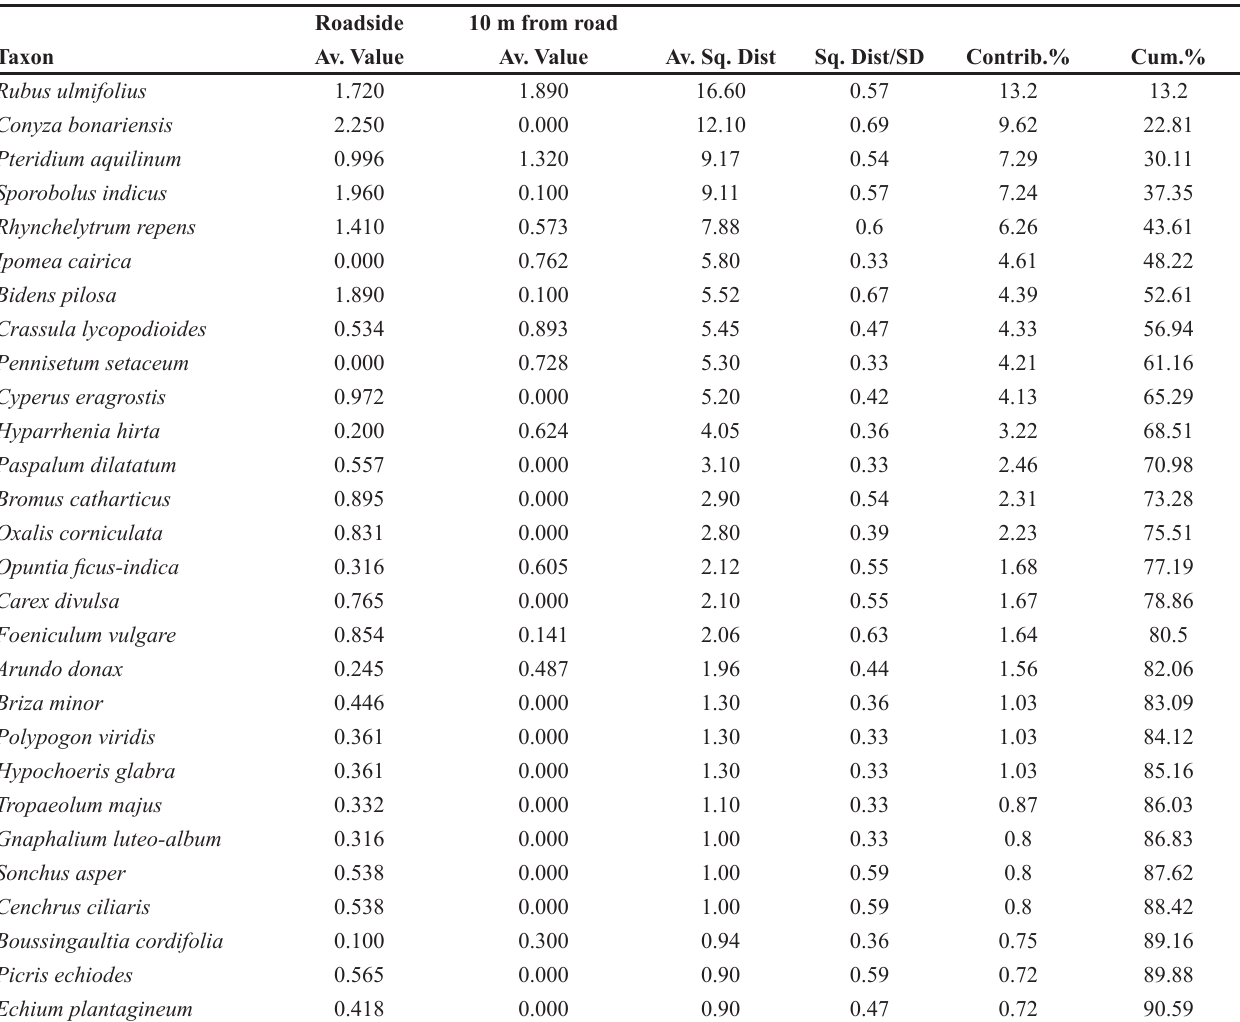
Table 3 – Results of the SIMPER procedure conducted to determine species contribution to differences between anthropic areas (roadsides) and non-anthropic (10 m from the roadside), in areas of laurel and thermophilic forest in Anaga Rural Park, (Tenerife, Canary Islands).